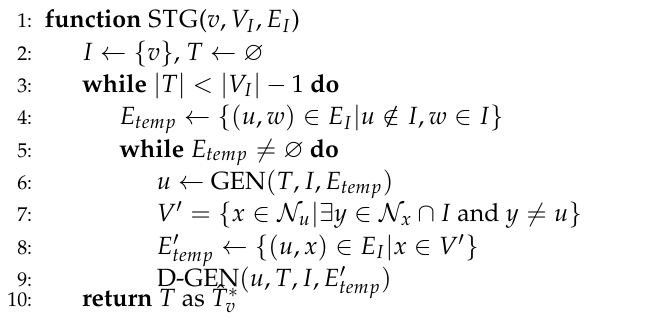
Algorithm 1 Sample-Tree Generation (STG)